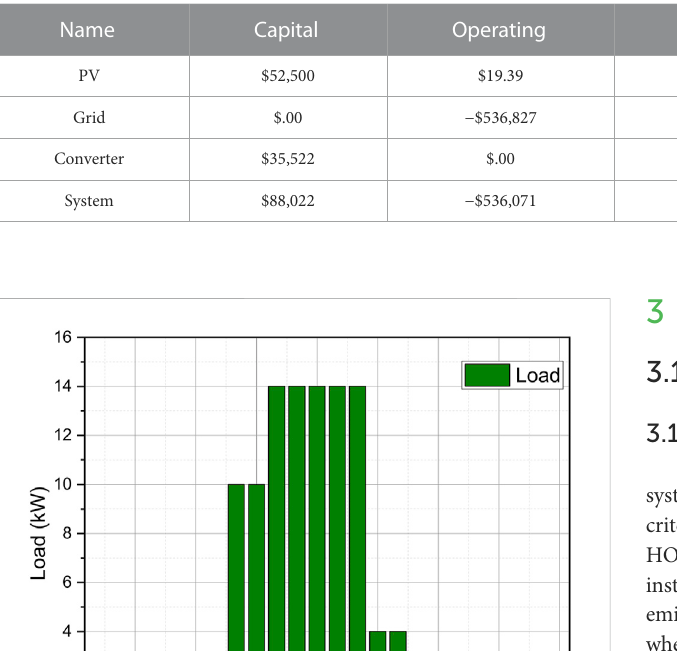
TABLE 4 Net present cost of the proposed system.